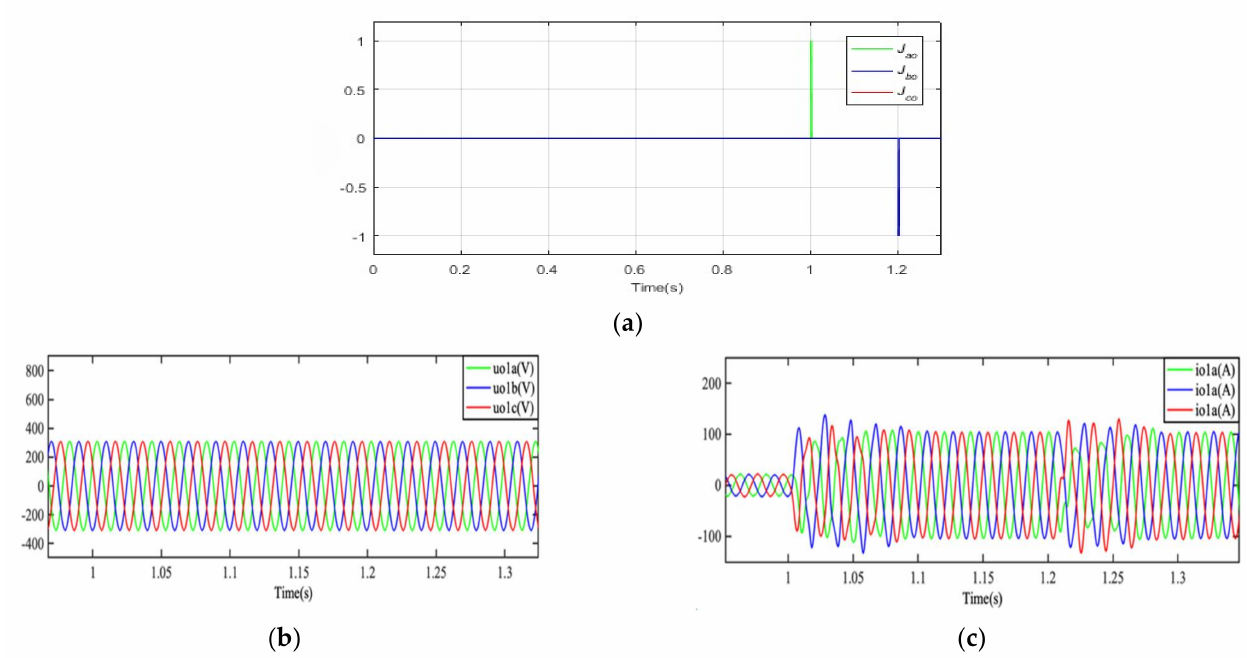
Figure 11. Operating mode 3. ( a ) The polarities of the inverter 1 midpoint voltages; ( b ) Output voltages of inverter 1; ( c ) Output currents of inverter